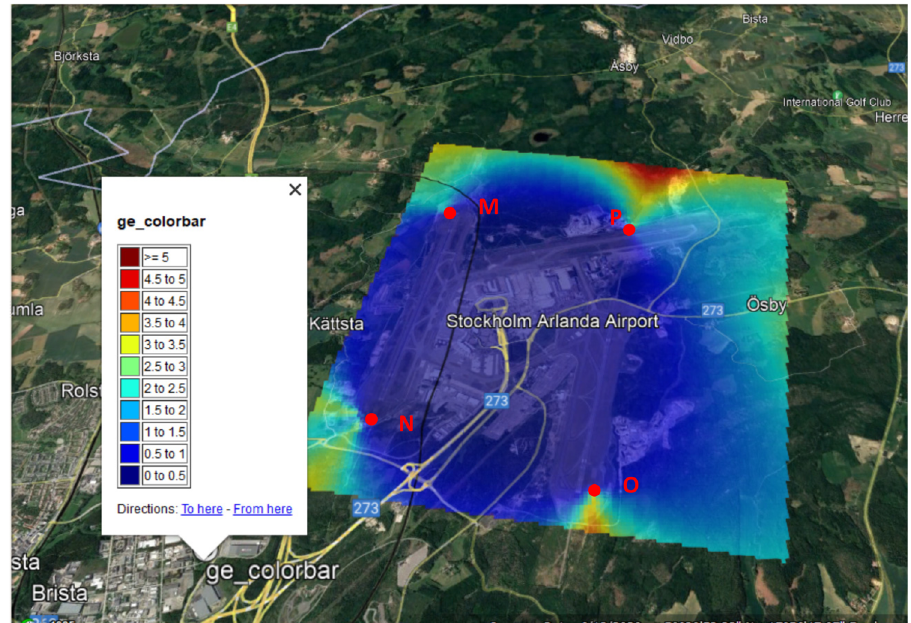
Figure 5: DOP of optimised wireless security network with search area and directional constraints over Arlanda international